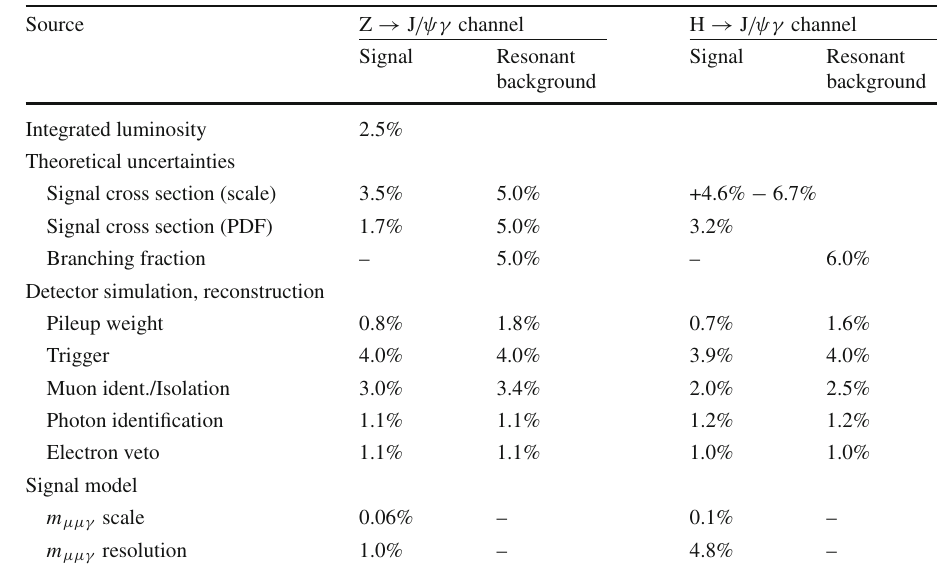
scripts and subscripts. The third column presents the Z decay branching fractions when the J /ψ is assumed to be produced with λ θ = + 1 or − 1, in the helicity